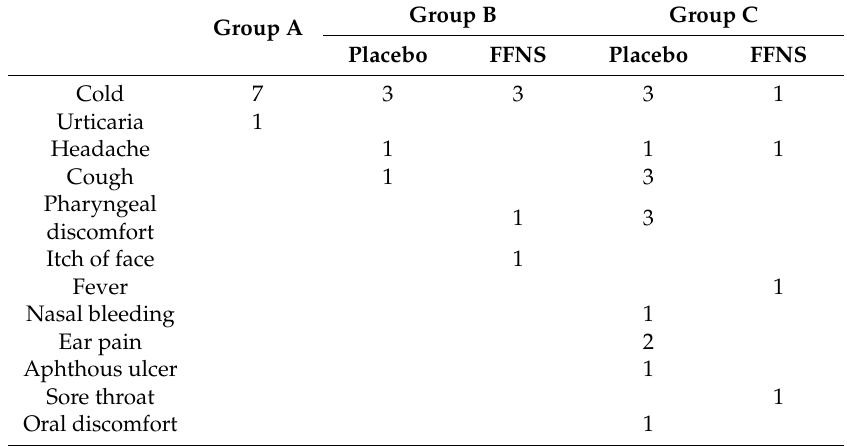
Table 3. Adverse events reported during the study regardless of their relationship to the treatment. Group B Group C Group A Placebo FFNS Placebo FFNS Cold 7 3 3 3 1